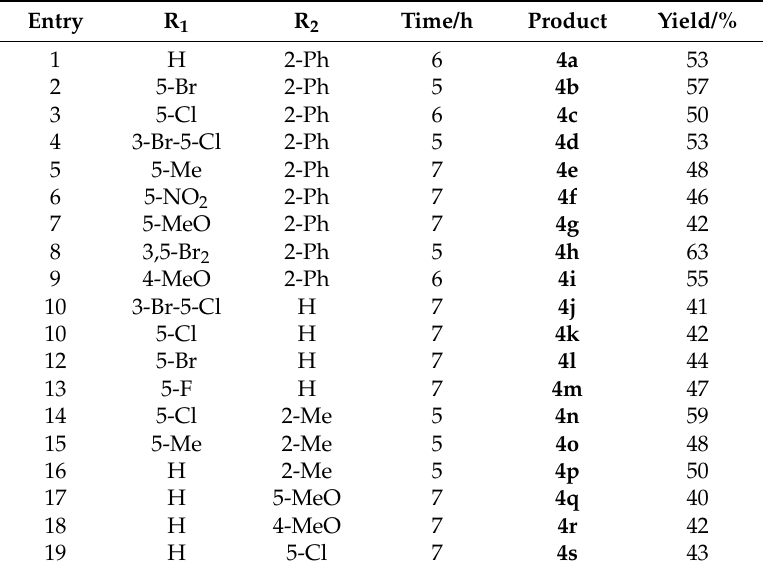
Table 2. Preparation of 1,4-naphthoquinones possessing indole scaffolds.